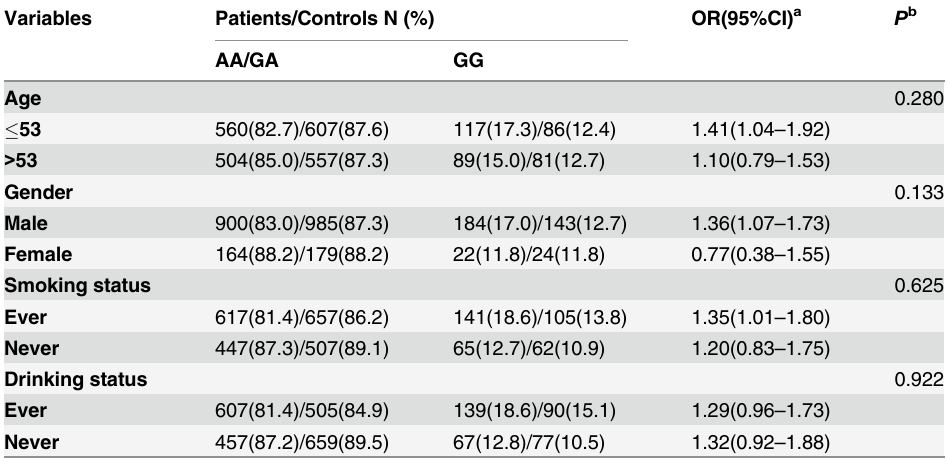
Table 5. Stratified analyses on association between rs7248320 genotypes and HCC